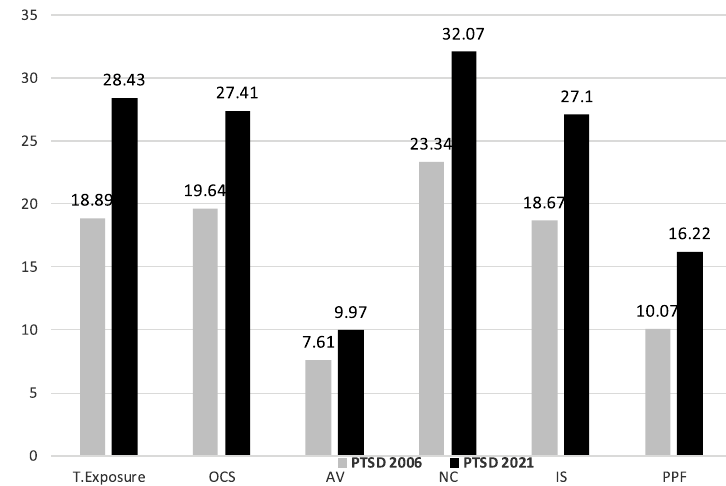
Fig. 1 Total trauma exposure and PTSD symptoms in2006 and 2021